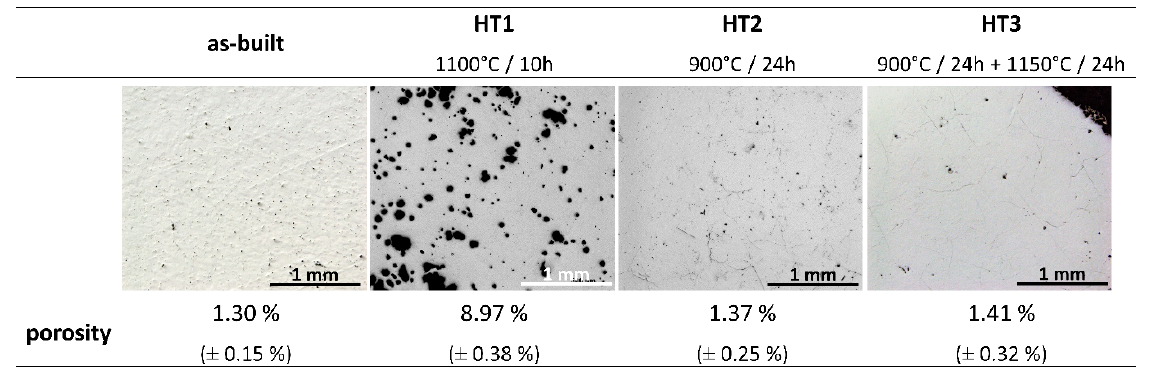
Figure 2. Light microscopic observation and porosity results of as-built sample; HT1 (1000 °C/10 h), HT2 (900 °C/24 h), and HT3 (900 °C/24 h + 1150 °C/24 h) heat-treated samples.